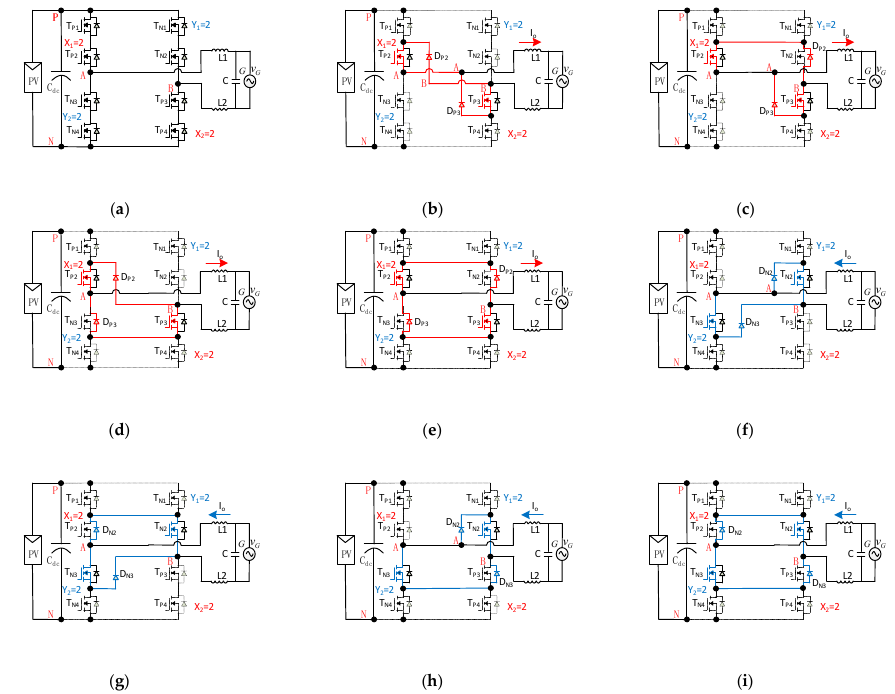
Figure 17. Four modes under X 1 = 2, X 2 = 2, Y 1 = 2, and Y 2 = 2. ( a ) PC and NC modes; ( b ) PF mode #1; ( c ) PF mode #2; ( d ) PF mode #3; ( e ) PF mode #4; ( f ) NF mode #1; ( g ) NF mode #2; ( h ) NF mode #3; ( i ) NF mode #4.